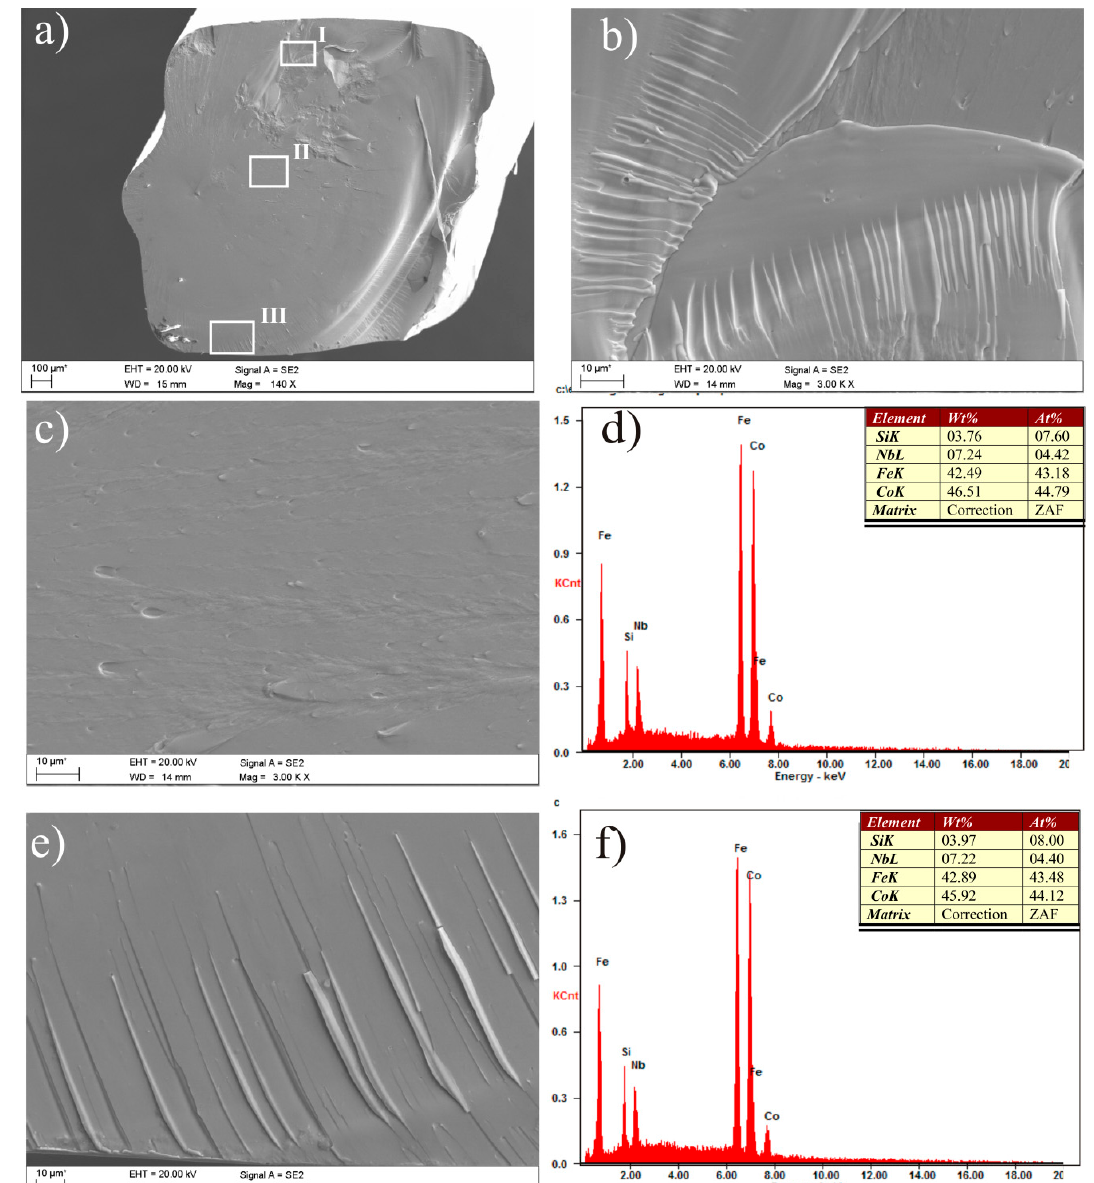
Figure 10. TEM image of the Fe 36.00 Co 36.00 B 19.00 Si 5 Nb 4 Fe 35.75 Co 35.75 B 18.90 Si 5 Nb 4 Cu 0.6 alloy in rod form with the diameter of 2.5 mm, ( a ) bright field; ( b ) the electron diffraction from the position marked SAD in (a); solution of diffraction: (Fe,Co)B 2 phase.